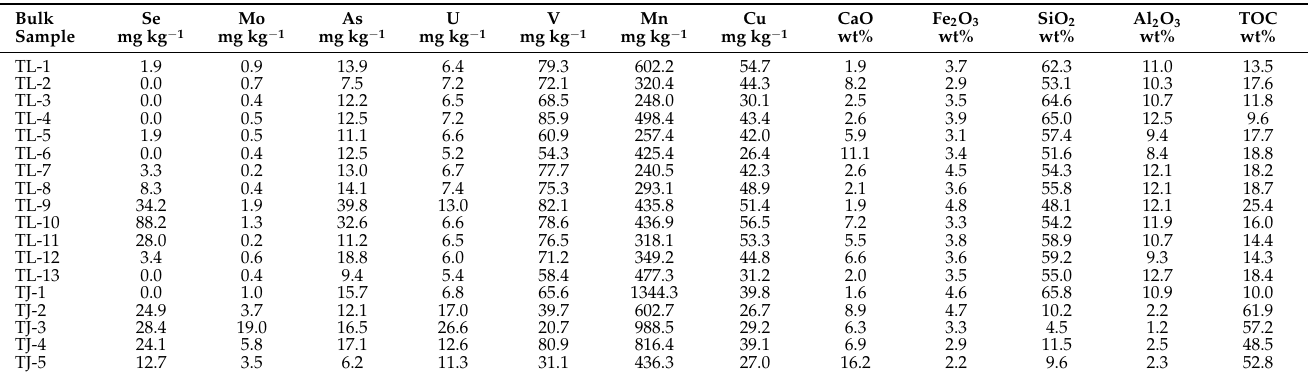
Table A3. X-ray fluorescence data showing the concentration of selected major and trace elements in soil samples collected at 10–20 cm depth at sites TL and TJ. TOC by loss on ignition.